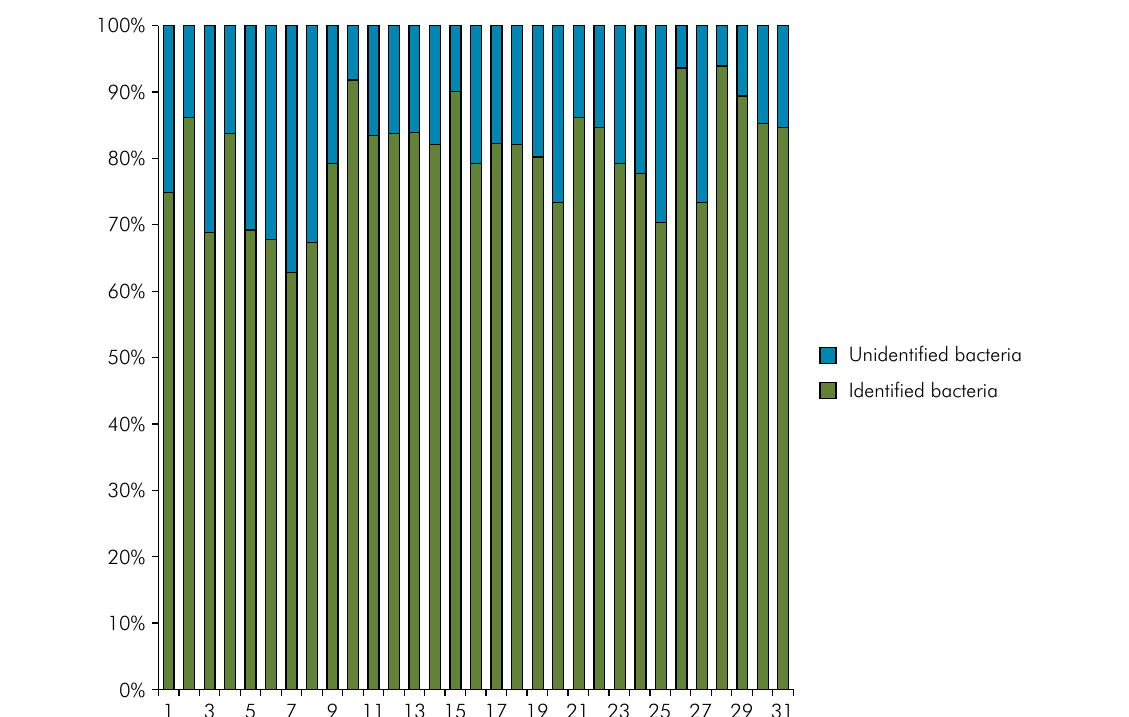
Figure 1. Average proportion of identified bacteria with the microorganisms stained with DAPI in all 31 primary teeth with pulp